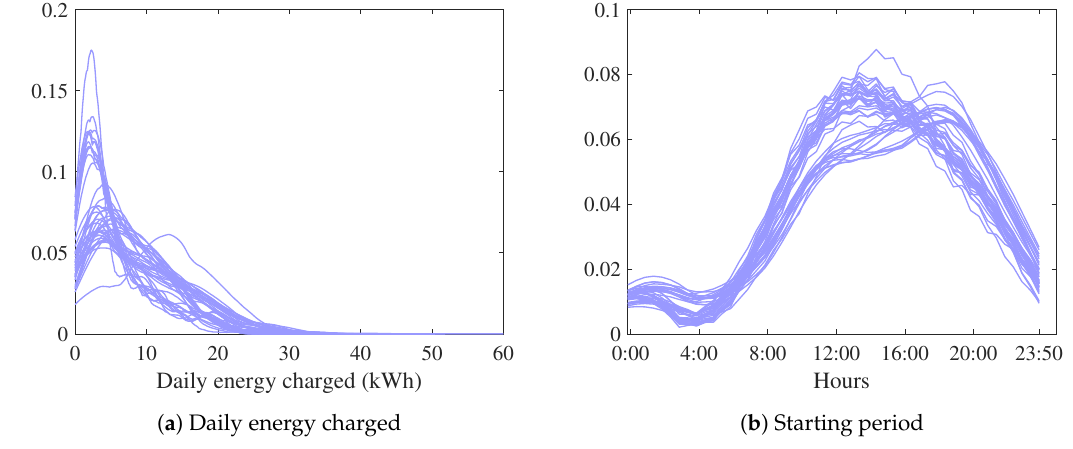
Figure 8. Case study: probability distributions of the daily energy charged and the starting hour of the charging per